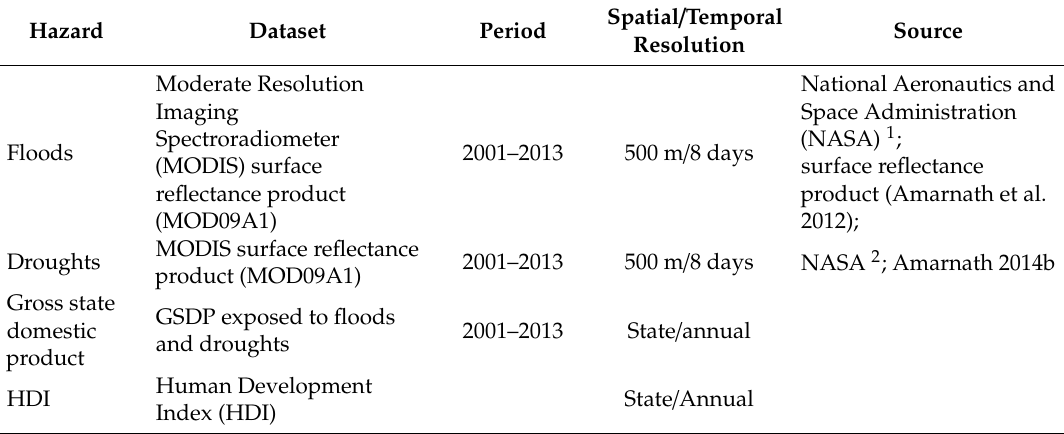
Table 2. List of data sources used in the impact analysis.